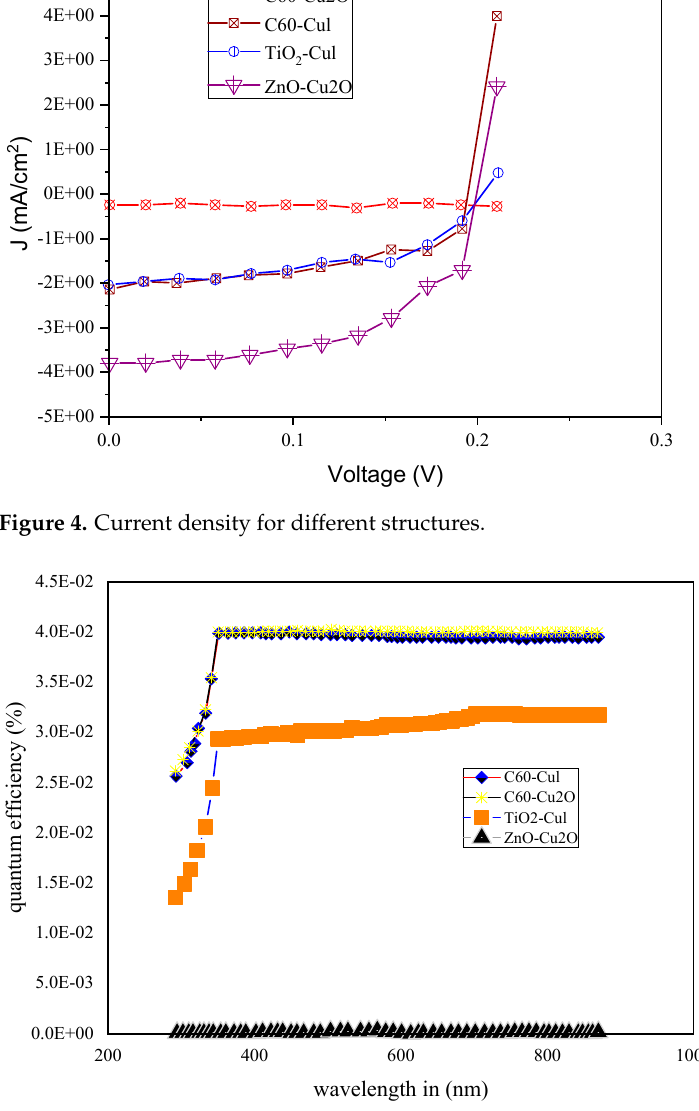
Figure 5. Quantum efficiency curve for different structures. Table 2. Extracted results from the proposed